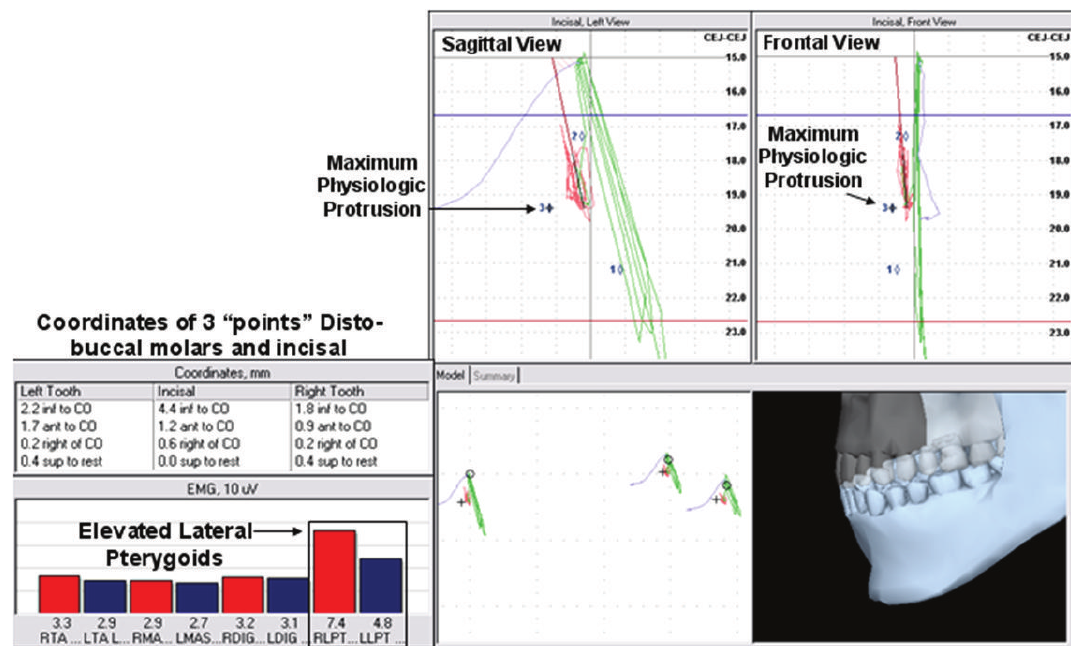
Figure 9: Spatial position of the lower jaw combined with bilateral activity of the temporalis anterior (TA), masseter (MAS), suprahyoid (DIG), and lateral pterygoid (LPT) sites. Coordinates listed are representative of mandibular position relative to centric occlusion and physiologic rest and were documented during the “burst” of LP activity and determined to be “Maximum Physiologic Protrusion”. Table 1: Summary of associated mandibular coordinates relative to physiologic parameters, determined by simultaneous monitoring of masticatory muscle activity. Right posterior jaw Incisal point Right posterior jaw 2.5 mm inferior to CO, and 0.3mm 4.4mm inferior to CO, 0.1 anterior 2.2 mm inferior to CO, and Physiologic rest anterior. and to the right. 0.3 mm anterior. 6.2mm inferior to centric